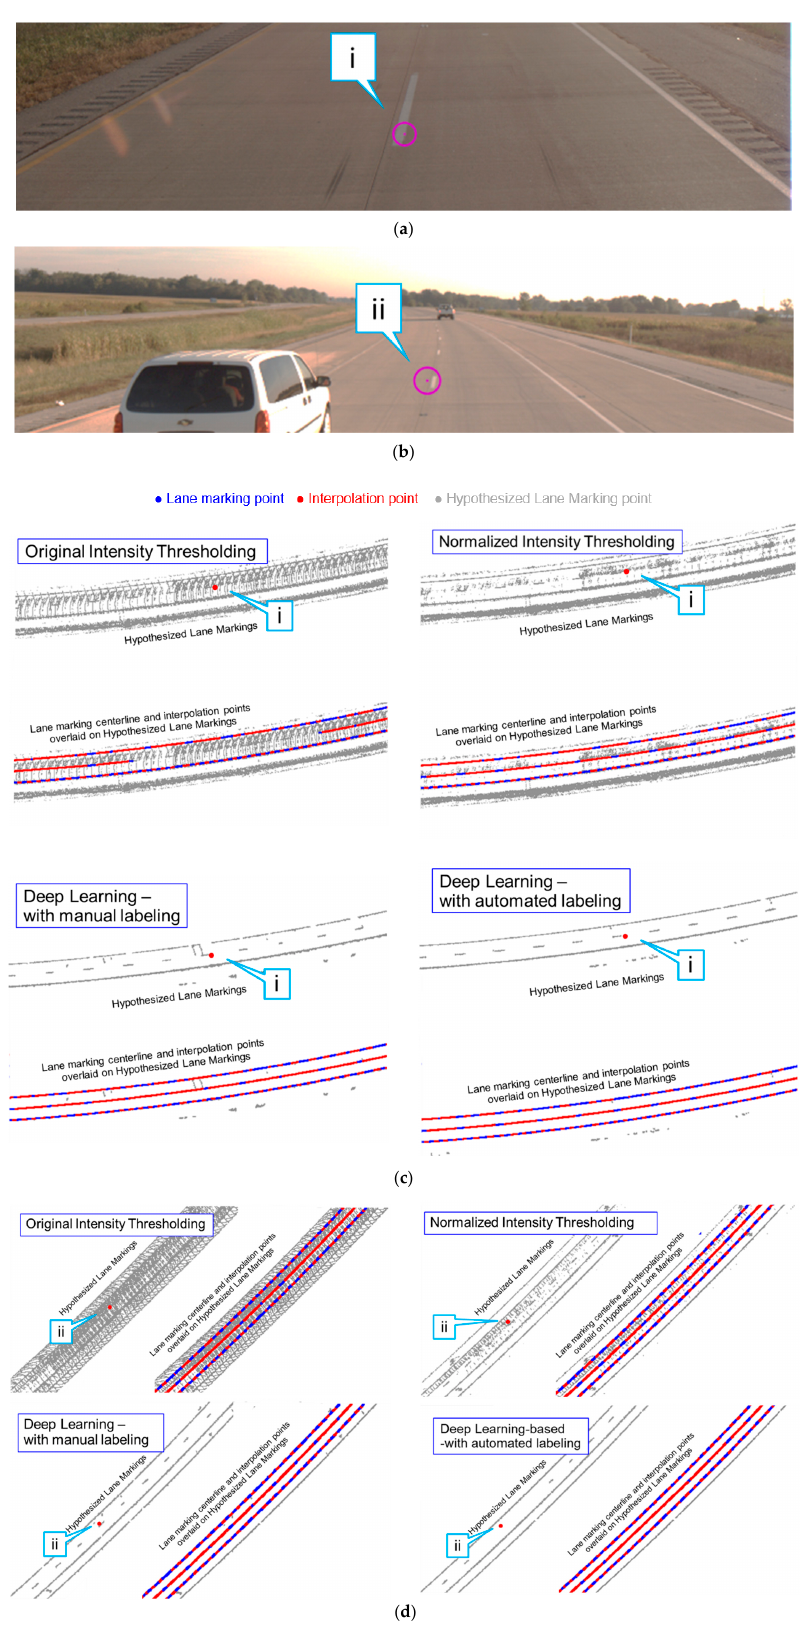
Figure 31. Estimated lane width values in ( a ) lane 1 and ( b ) lane 2 for dataset 3.